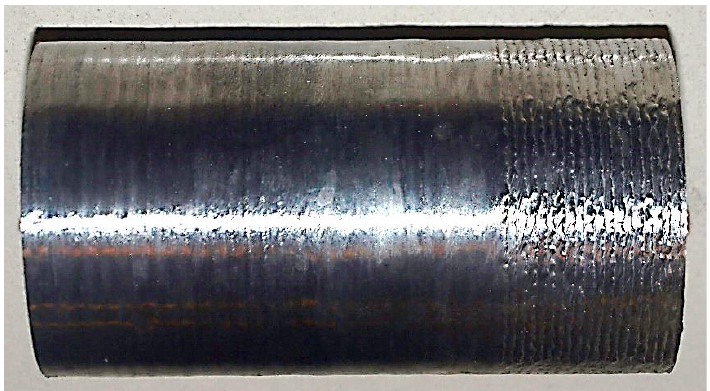
Figure 3. General view of Inconel 718 coating cladded by MAG method (right side); left side after additional TIG remelting in second stage.